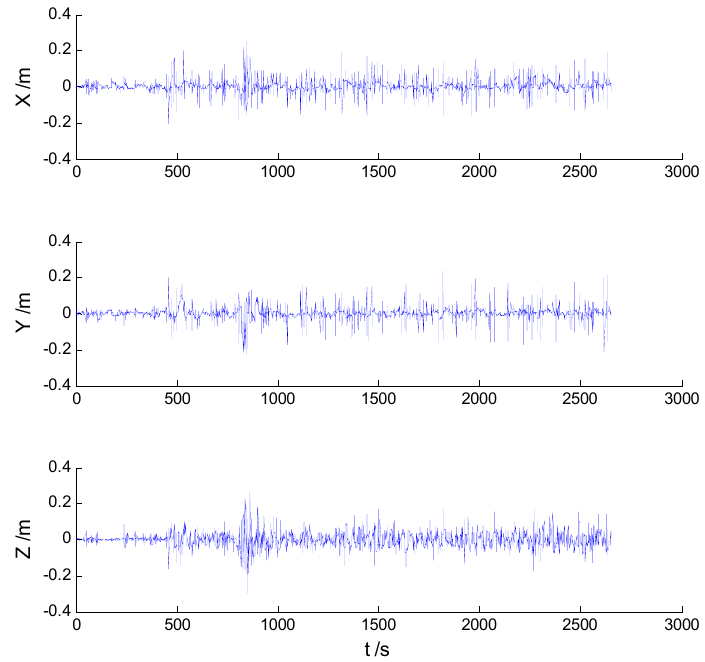
Figure 5. Position errors of the adaptive H-infinity filter (AHF) algorithm.